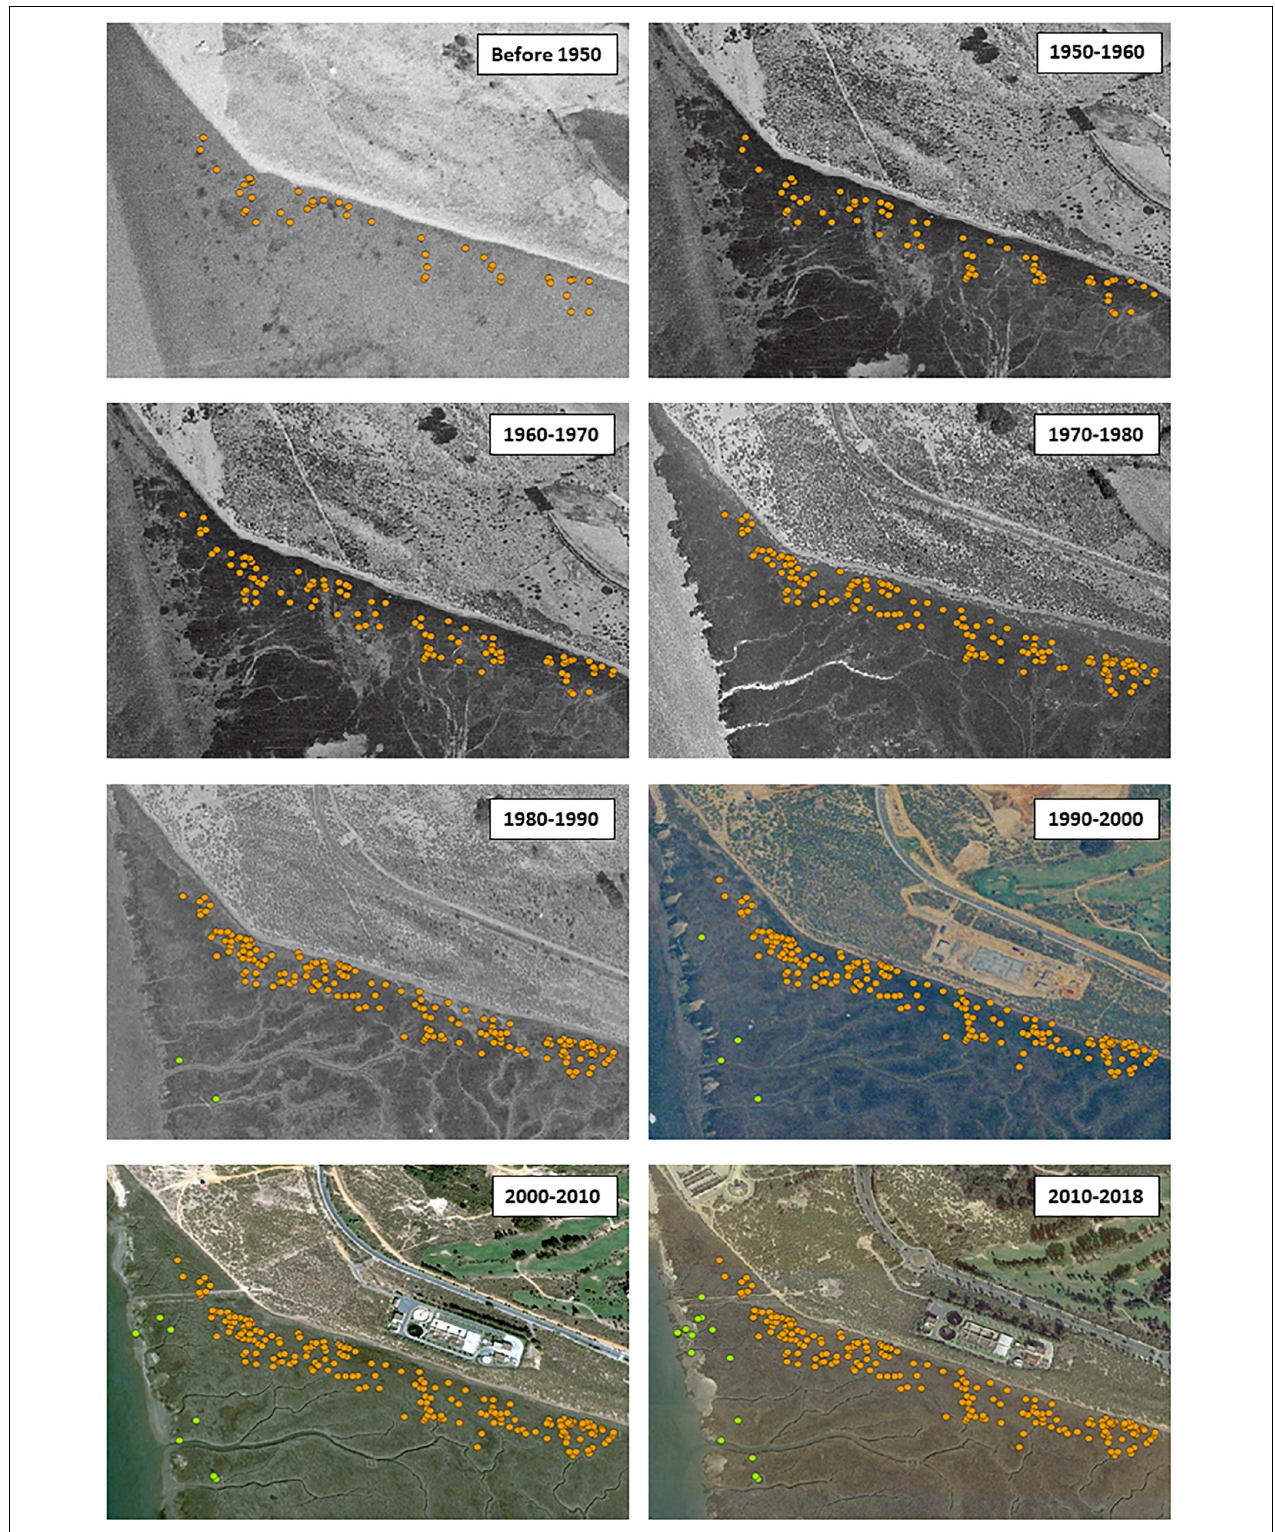
FIGURE 4 | Historical spatial distribution of the hybrids Spartina maritima × densiflora (green symbols) and S. densiflora × maritima (orange symbols) in San Bruno Marsh (Guadiana Estuary, Southwest Iberian Peninsula), before 1950, 1950–1960 (aerial photography of 1956), 1960–1970 (aerial photography of 1956), 1970–1980 (aerial photography of 1973), 1980–1990 (aerial photography of 1984), 1990–2000 (aerial photography of 1996), 2000–2010 (aerial photography of 2005), and 2010–2018 (aerial photography of 2017).